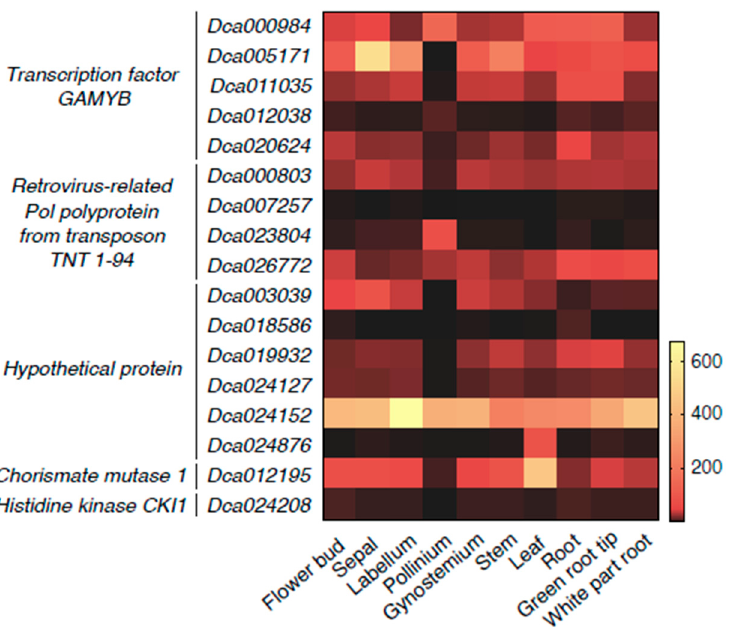
Figure 6 . Expression patterns of predicted D. officinale miR159-targeted genes in different tissues. FPKM values of 28 predicted miR159-targeted genes were extracted from transcriptome sequencing data of 10 tissues in D. officinale using orchidbase. A total of 17 predicted miR159-targeted genes with FPKM values >1 were presented in the heat map, which was divided into 5 categories. The FPKM values ranged from 0 (black) to 600 (yellow).